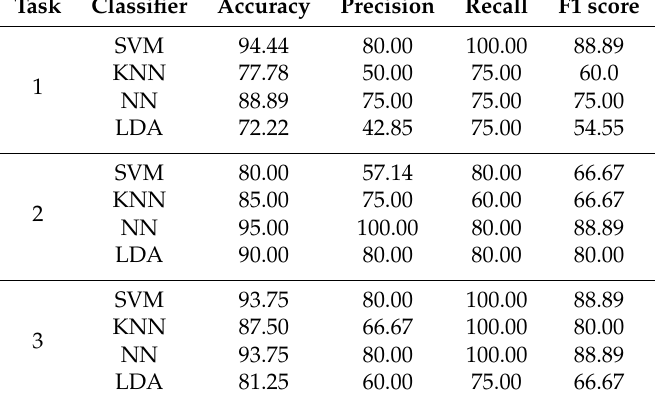
Table 3. Accuracy, precision, recall, and F1 score as percentages when the normalized energy-based metrics of both the instrument and the arthroscope are used as inputs of the classifiers.